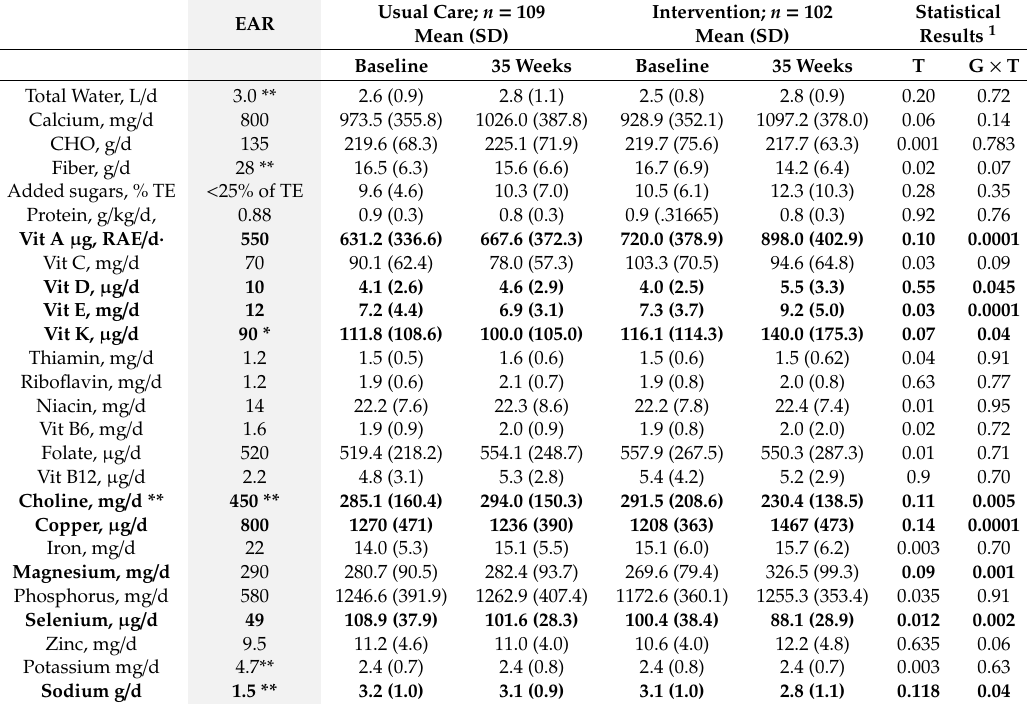
Table 3. Micronutrient intake from early pregnancy (baseline) to 35 weeks of gestation by treatment